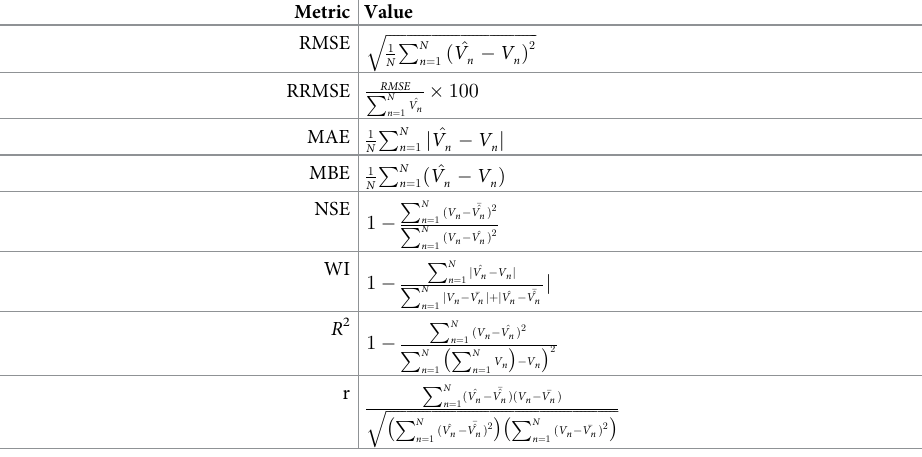
Table 3. The evaluation metrics used in assessing the prediction results based on the proposed optimization